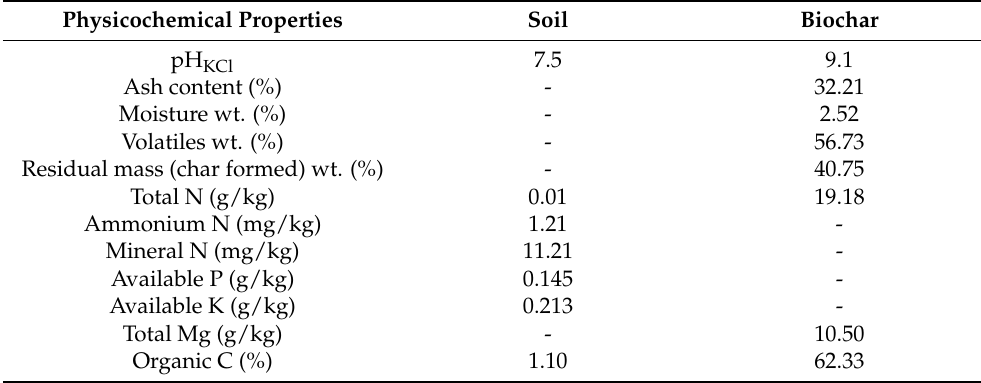
Table 1. Physicochemical characteristics of the soil and biochar under experimental trial. Physicochemical Properties